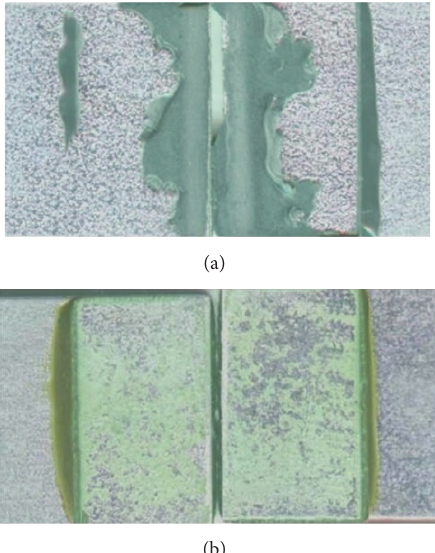
= C Figure 6: Fracture surfaces of bonded joints for adhesive (a) type A and (b) type B.